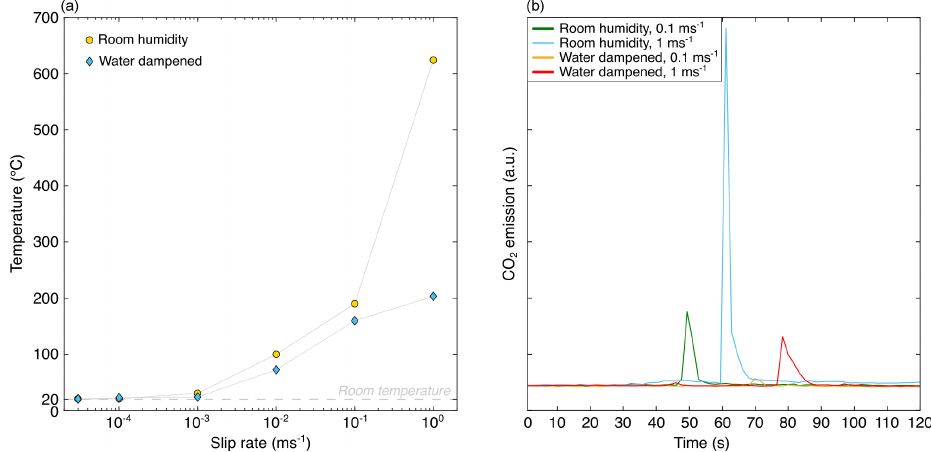
Figure 5. Peak temperatures and CO 2 emissions. (a) Maximum temperature measured by the thermocouple located closest to the gouge layer (see Fig. 1b for location). (b) CO 2 emissions for experiments at V ≥ 0 . 1ms − 1 in both room-humidity and water-dampened conditions. Greater emissions occur at room-humidity conditions, but smaller and distinct peaks are also observed in the presence of